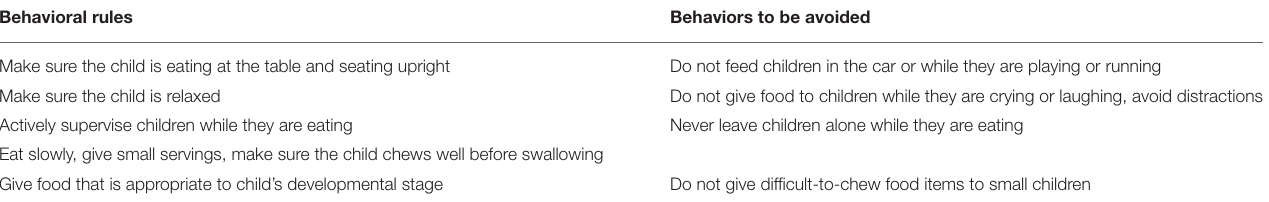
TABLE 3 | Behavioral rules at mealtimes. Behavioral